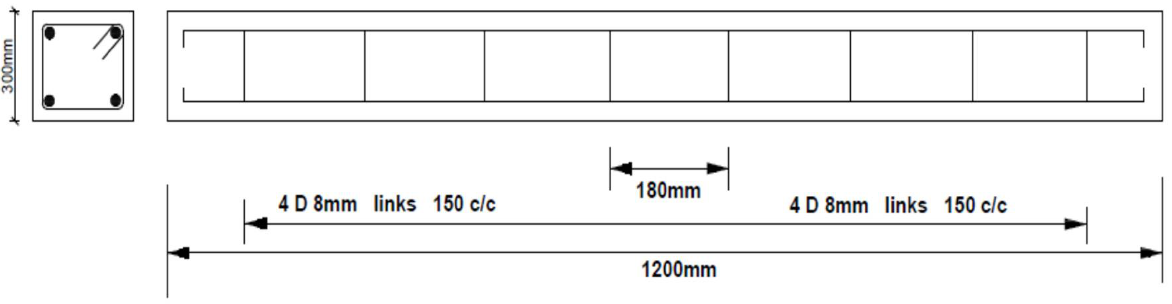
Figure 3. Beam reinforcement details.